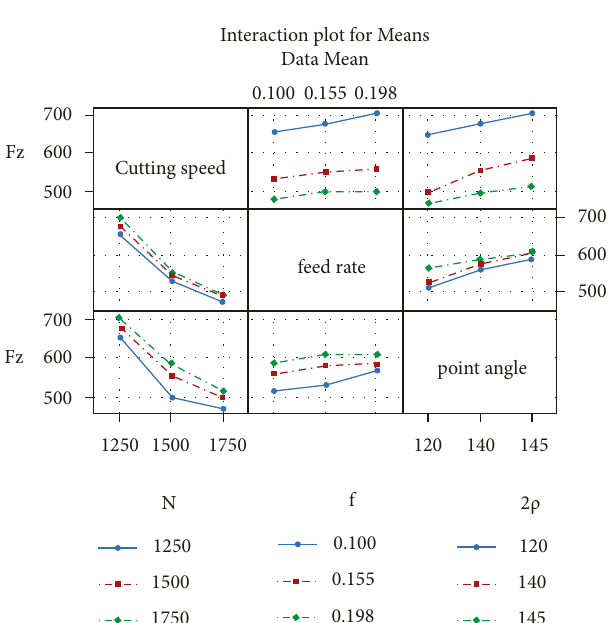
Figure 2: Interaction plot for means: cutting